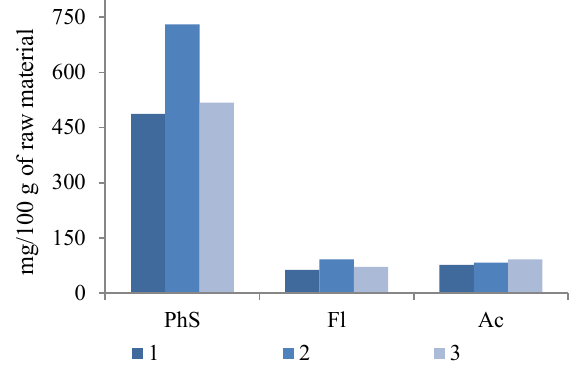
Table 2 Antioxidant properties of the raspberry extracts